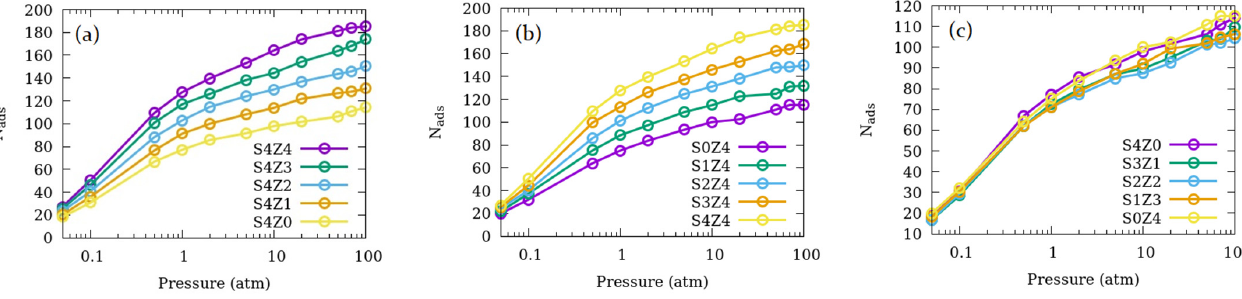
Figure 4. Adsorption isotherms of ethane in silicalite from GCMC simulations of ( a ) S-majority, ( b ) Z-majority, and ( c ) half-blocked models as included in Table 1.